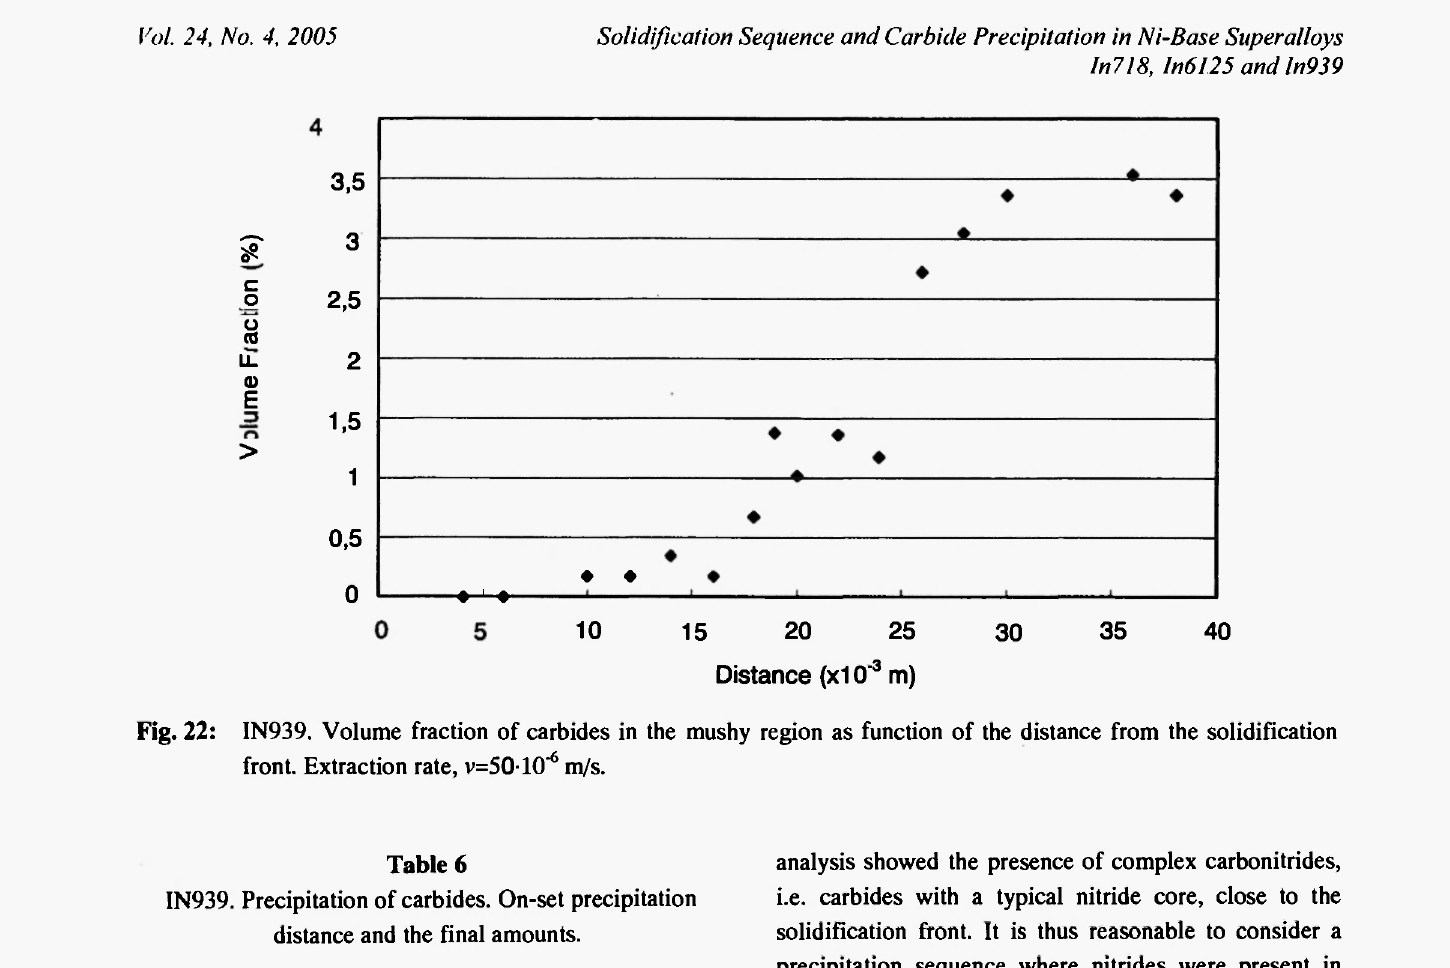
IN939. Precipitation of carbides. On-set precipitation distance and the final